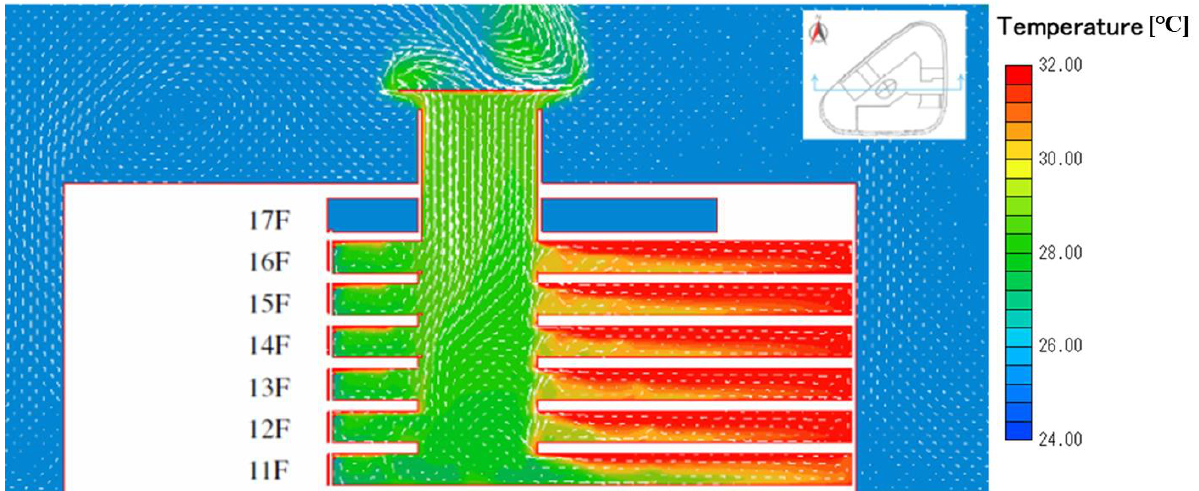
Figure 14. Temperature distribution with ambient temperature at 26 °C.